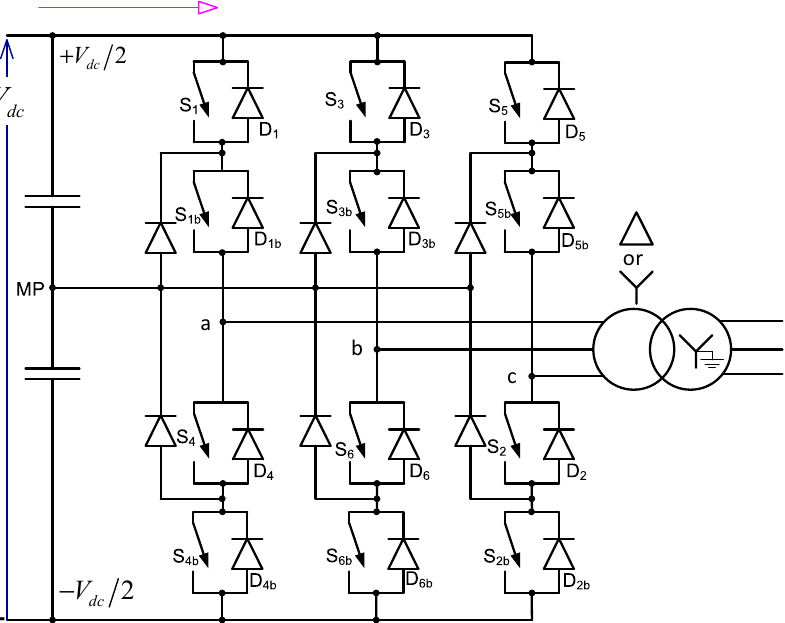
Figure 21. 3-Level Neutral-clamped converter.